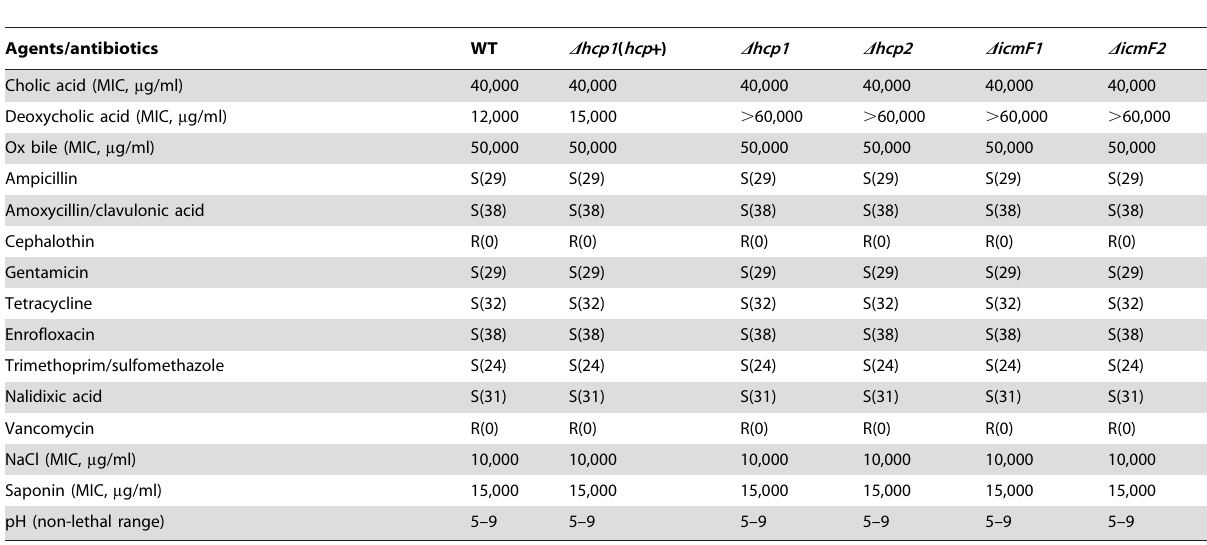
Table 2. Responses of WT C. jejuni ATCC 43431, D hcp and D icmF mutants, and the complemented D hcp1 ( hcp1 ( hcp + )) to bile salts, NaCl, saponin, different pH and